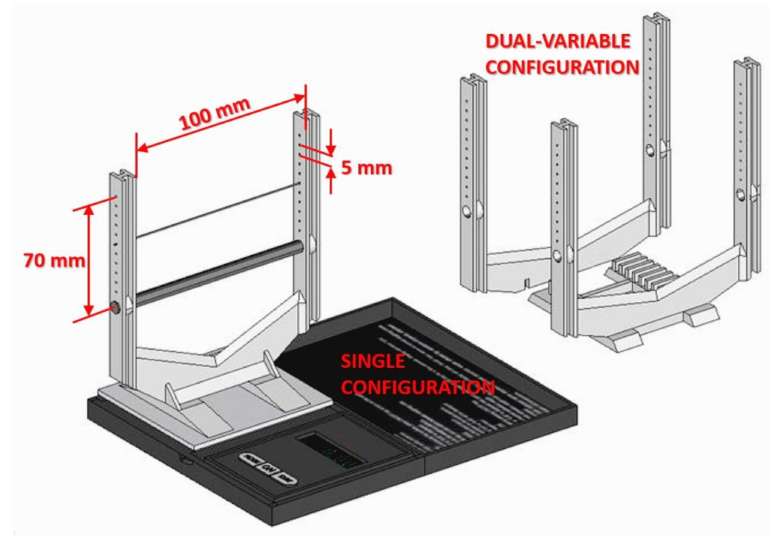
Figure 2. General view of the thrusters.